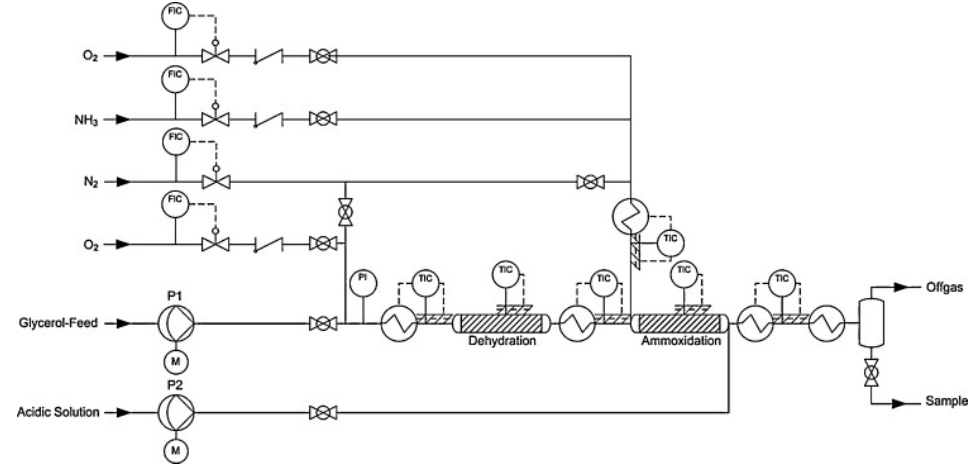
Figure 19. Reactor setup for the tandem process (Copyright of Elsevier, see [52]). The results previously described are reported in Table 19. Use of TiO 2 as catalyst in continuous flow production of biodiesel and glycerol recovery.